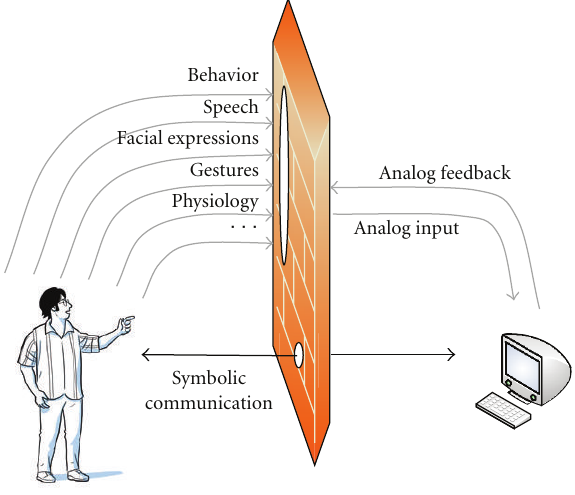
Figure 2: Enriched human-computer interaction by additional analog